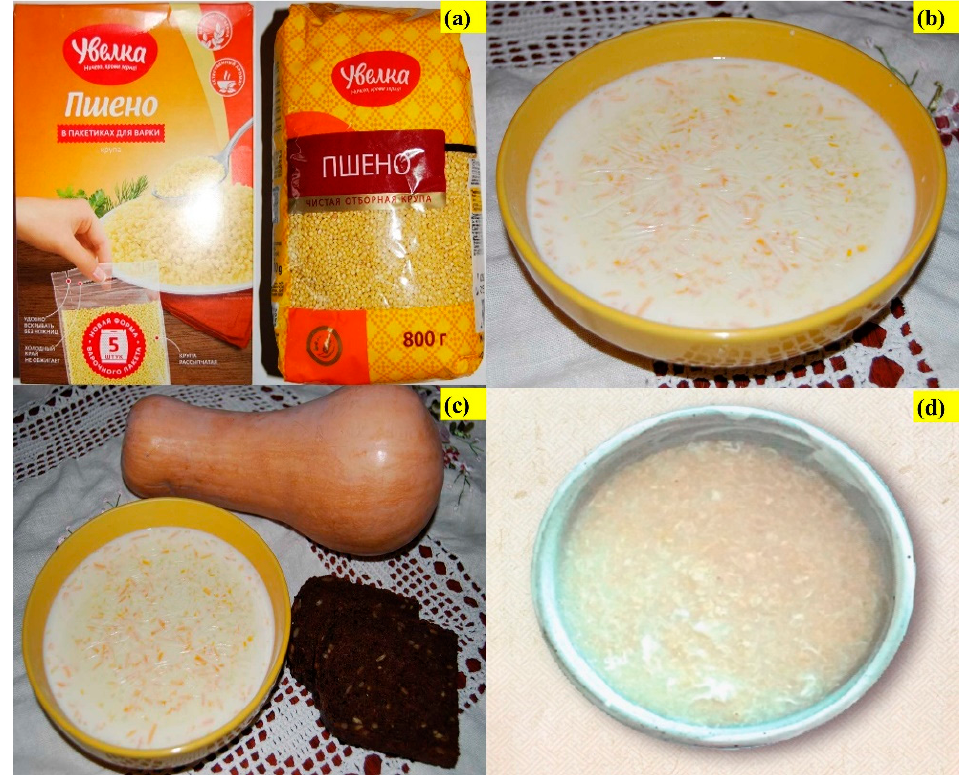
Figure 4. ( a ) Dehulled millet from Russia (groat) (Picture credit: Dr. Suvorova). ( b , c ) Proso millet milk porridge with pumpkin (Picture: Dr. Galina Suvorova); ( d ) porridge from Korea cooked with water, egg and honey. (Picture credit: Dr. Hijin Kim and Dr. Cheol Ho Park).